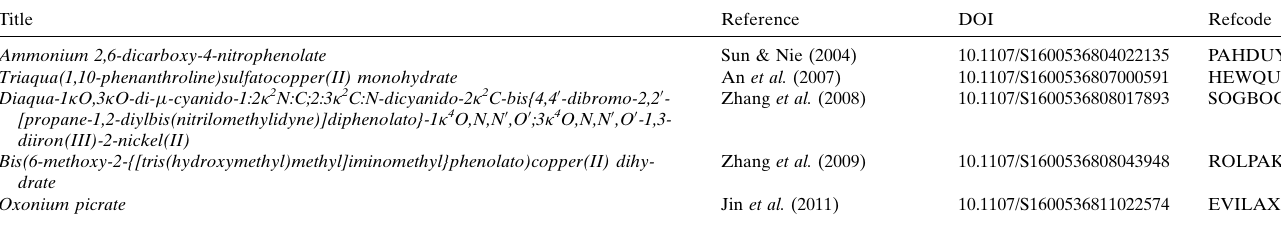
Details of articles to be retracted, in order of